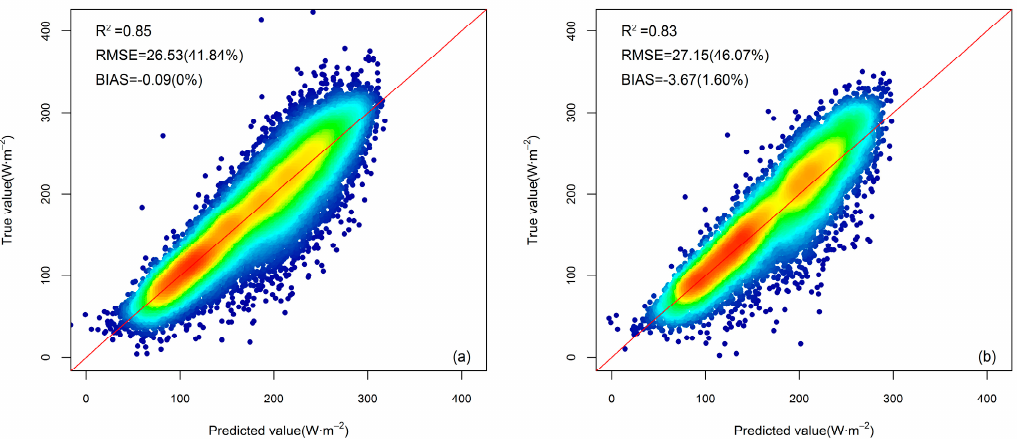
Figure 10. ( a ) Evaluation results of the training dataset’s daily estimated DSR based on the ANN-based clear sky model against ground measurements in 2001 and 2002. ( b ) Evaluation results of the validation dataset’s daily estimated DSR based on the ANN-based clear sky model against ground measurements in 2003. The number in the parentheses is the RMSE value.